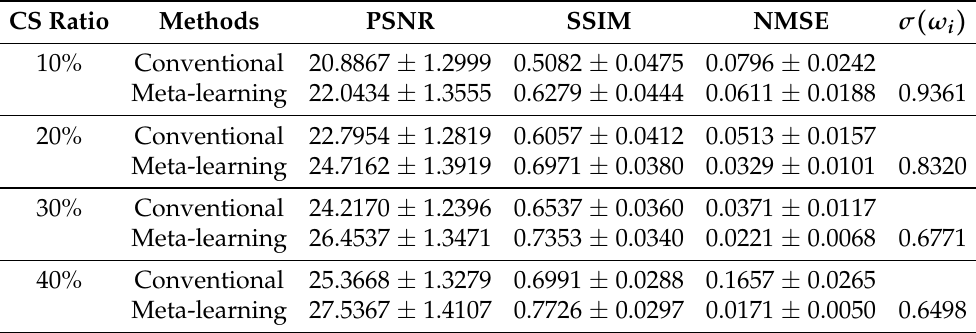
Table 5. Quantitative evaluations of the reconstructions of T2 brain image associated with various sampling ratios of random Cartesian